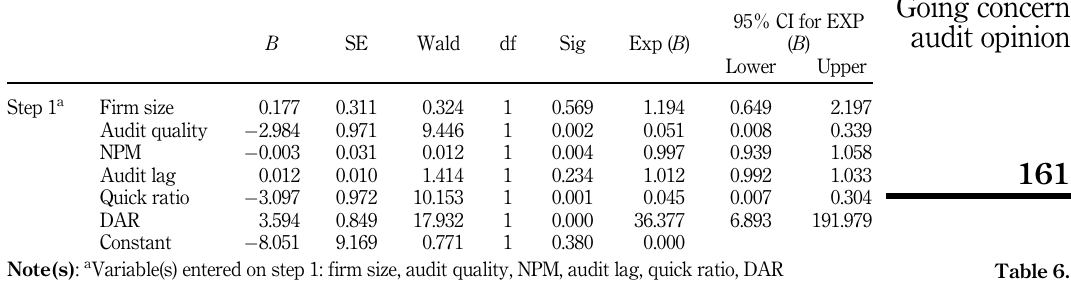
Table 6. Classification matrices